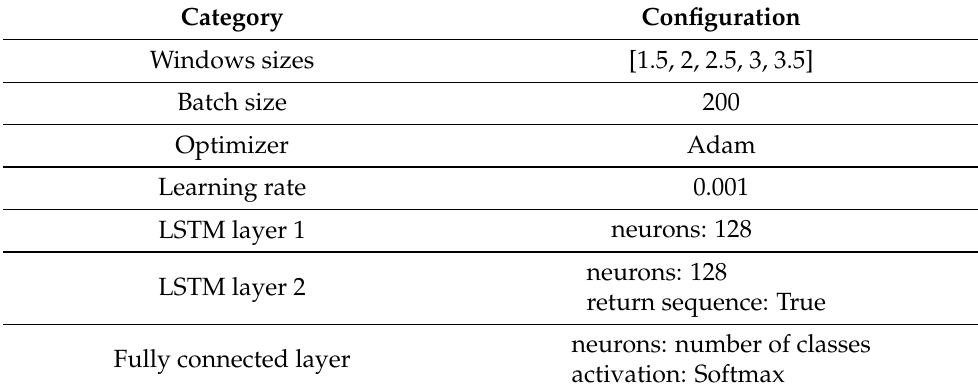
Table A4. UCI DTE LSTM model configuration.